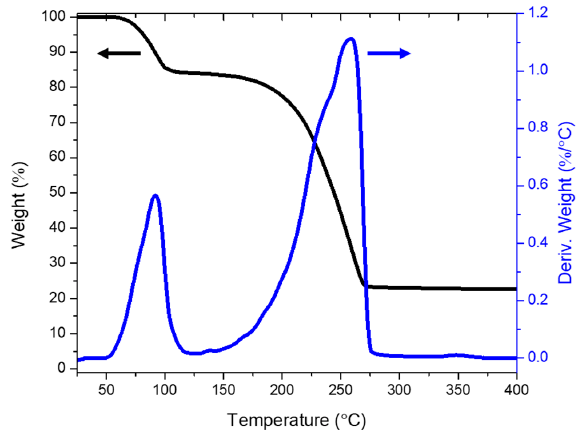
Figure 6. T hermogravimetric analysis (TGA) survey of zinc precursor in the air to study the formation of of ZnO.